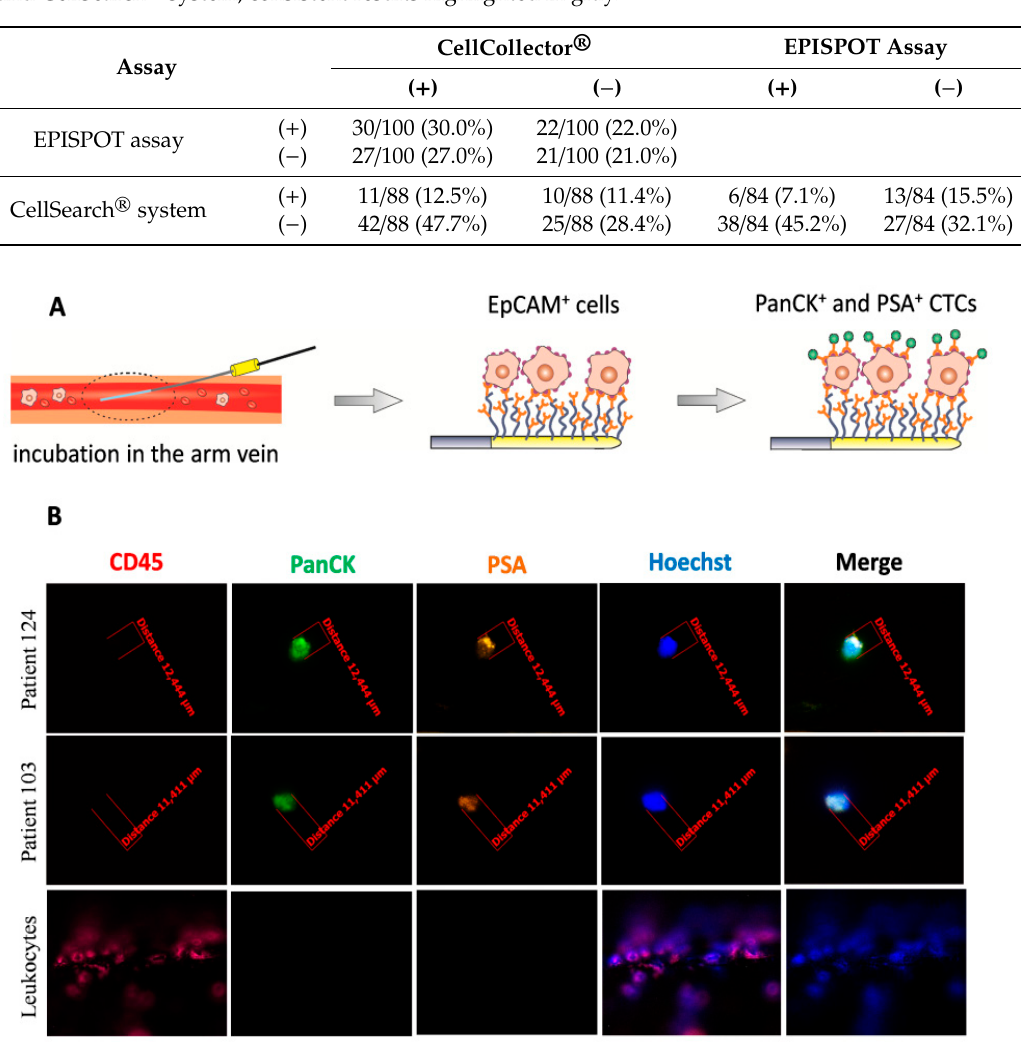
Table 3. Contingency table illustrating distribution of positive (at least one CTC in analyzed material) and negative (no CTCs) results obtained with the CellCollector ® , dual fluoro-EPISPOT PSA / FGF2 assay and CellSearch ® system; consistent results highlighted in gray.